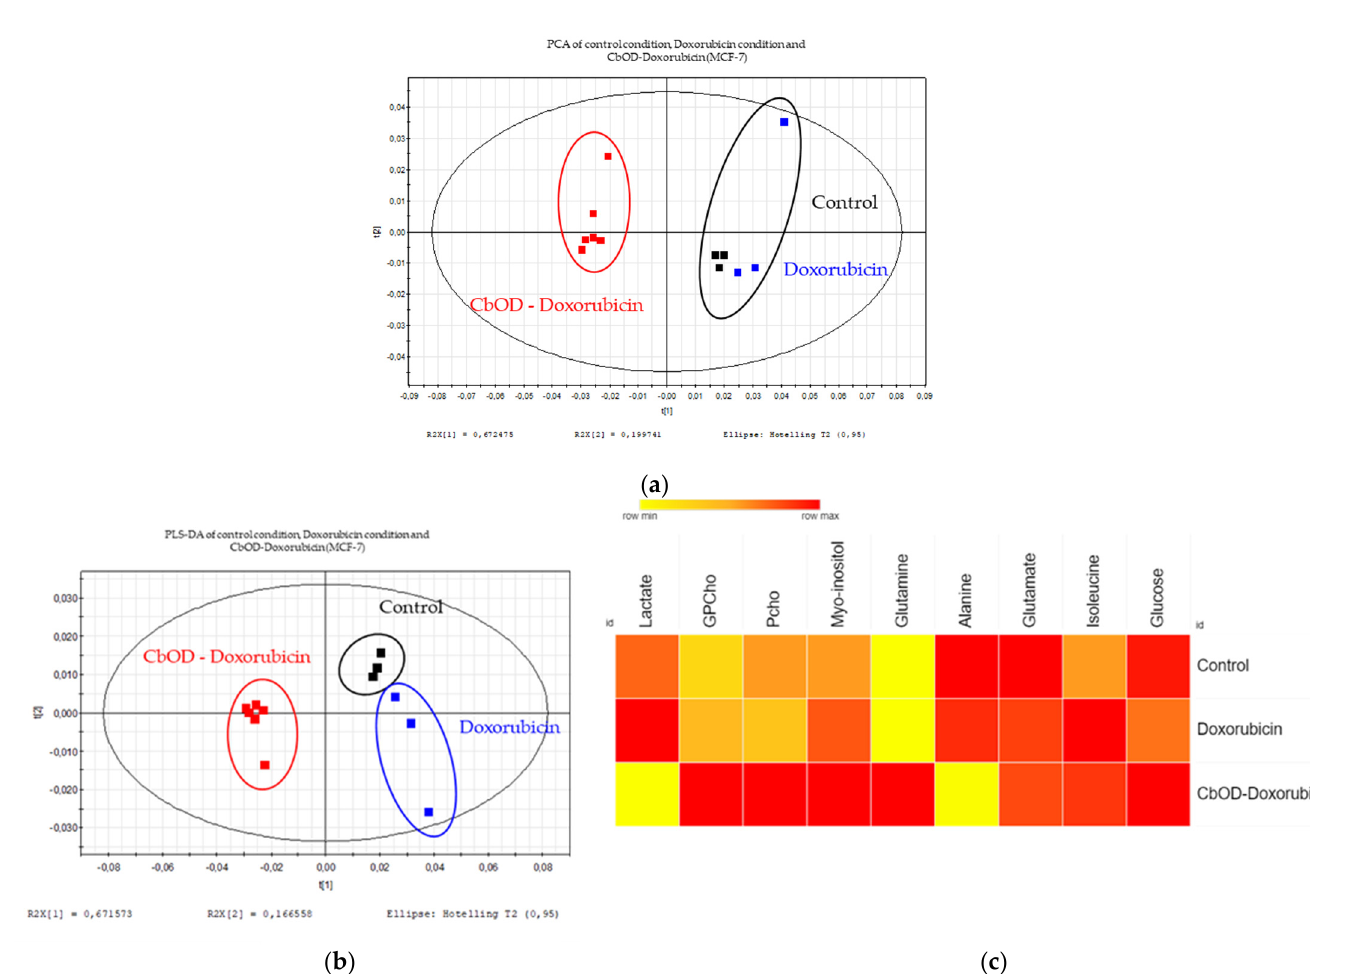
Figure 7. Impact on the MCF-7 metabolism. ( a ) Scores plot (PCA) of the intracellular spectra of the samples from the control cells (black), Doxorubicin-treated cells (blue) and CbOD/Doxorubicin-treated cells (red) in 234 variables. ( b ) Scores plot (PLS-DA) of the intracellular spectra of the samples from the control cells (black), Doxorubicin-treated cells (blue) and CbOD/Doxorubicin-treated cells (red) in 234 variables. ( c ) Heatmaps of the discriminant metabolites identified between the 3 conditions. n = 3 for Doxorubicin and the control conditions, and n = 6 for the CbOD-Doxorubicin condition.